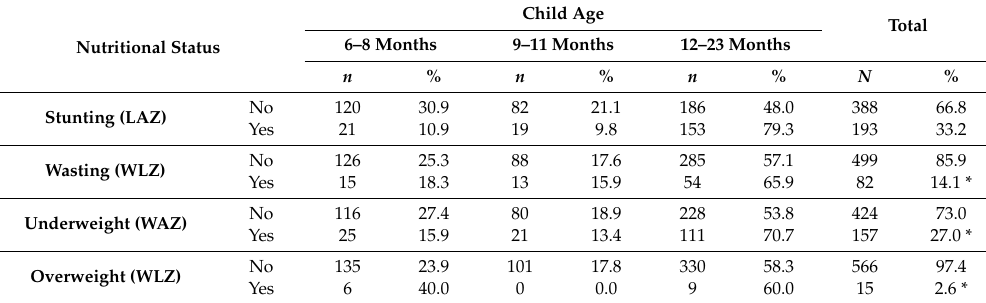
Table 3. Nutritional status of children by age ( n = 581).